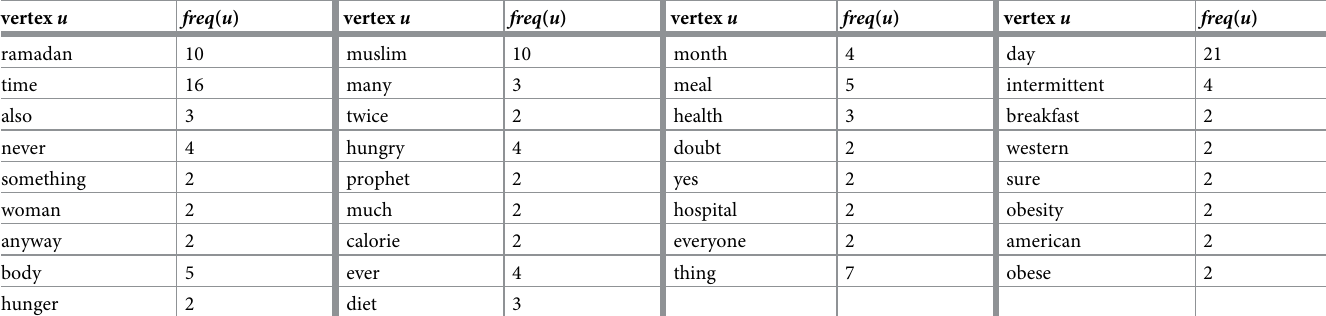
Table 1. High contributor singleton vertices in the text graph and their frequencies.